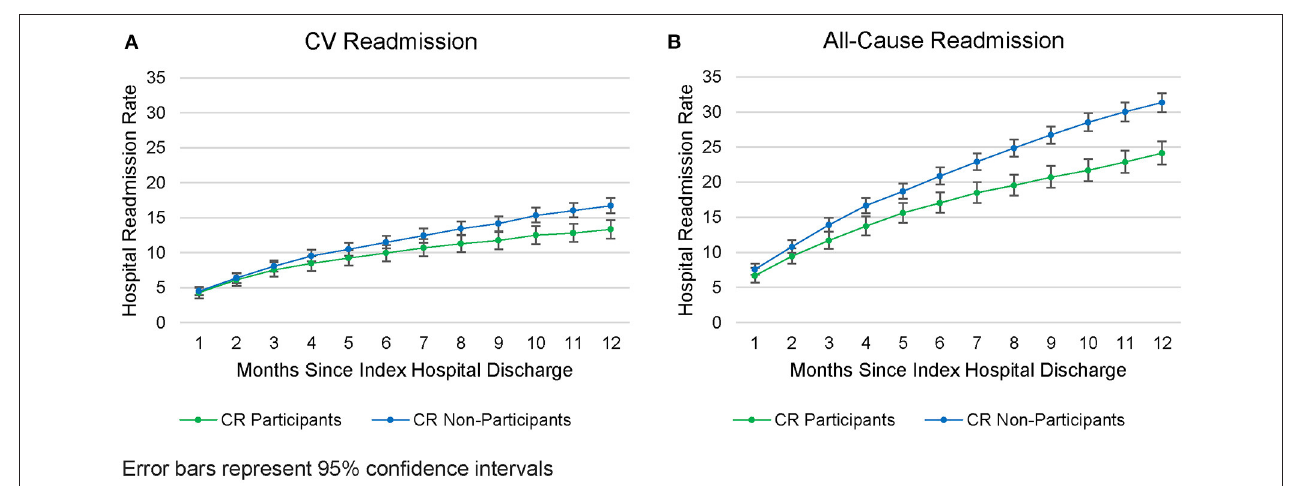
FIGURE 3 | Readmissions rates from the CAD population. (A) CV Readmission. (B) All-cause